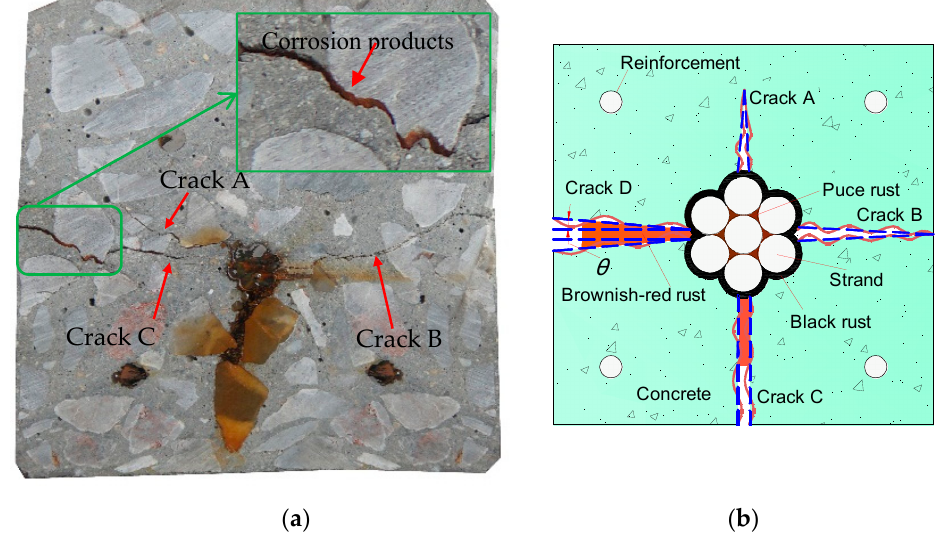
Figure 9. Schematic diagrams of the crack propagation: ( a ) Crack distribution; and ( b ) simplified crack propagation.